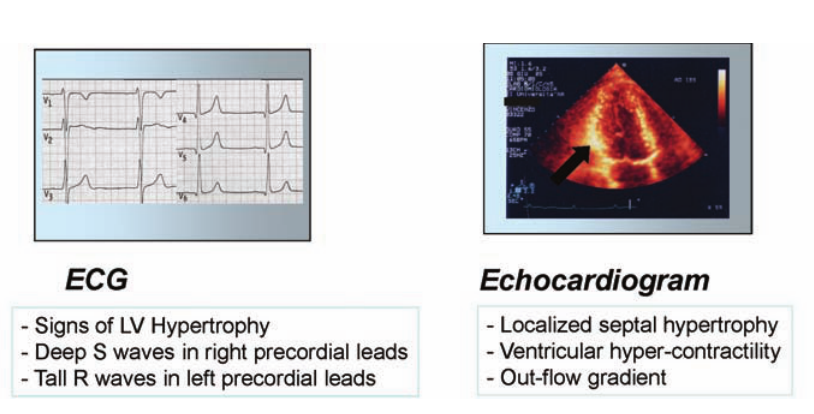
Figure 5. Hypertrophic stage of dystrophinopathic cardiomyopathy: elettrocardiograph- ic and echocardiographic